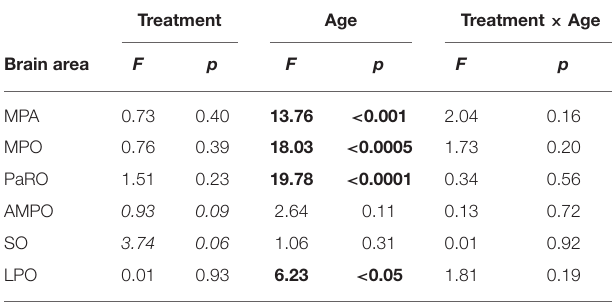
TABLE 2 | Statistical results of AVT-positive neuron count comparisons (Friedman’s Two-Way Nonparametric ANOVA). Treatment Age Treatment ×